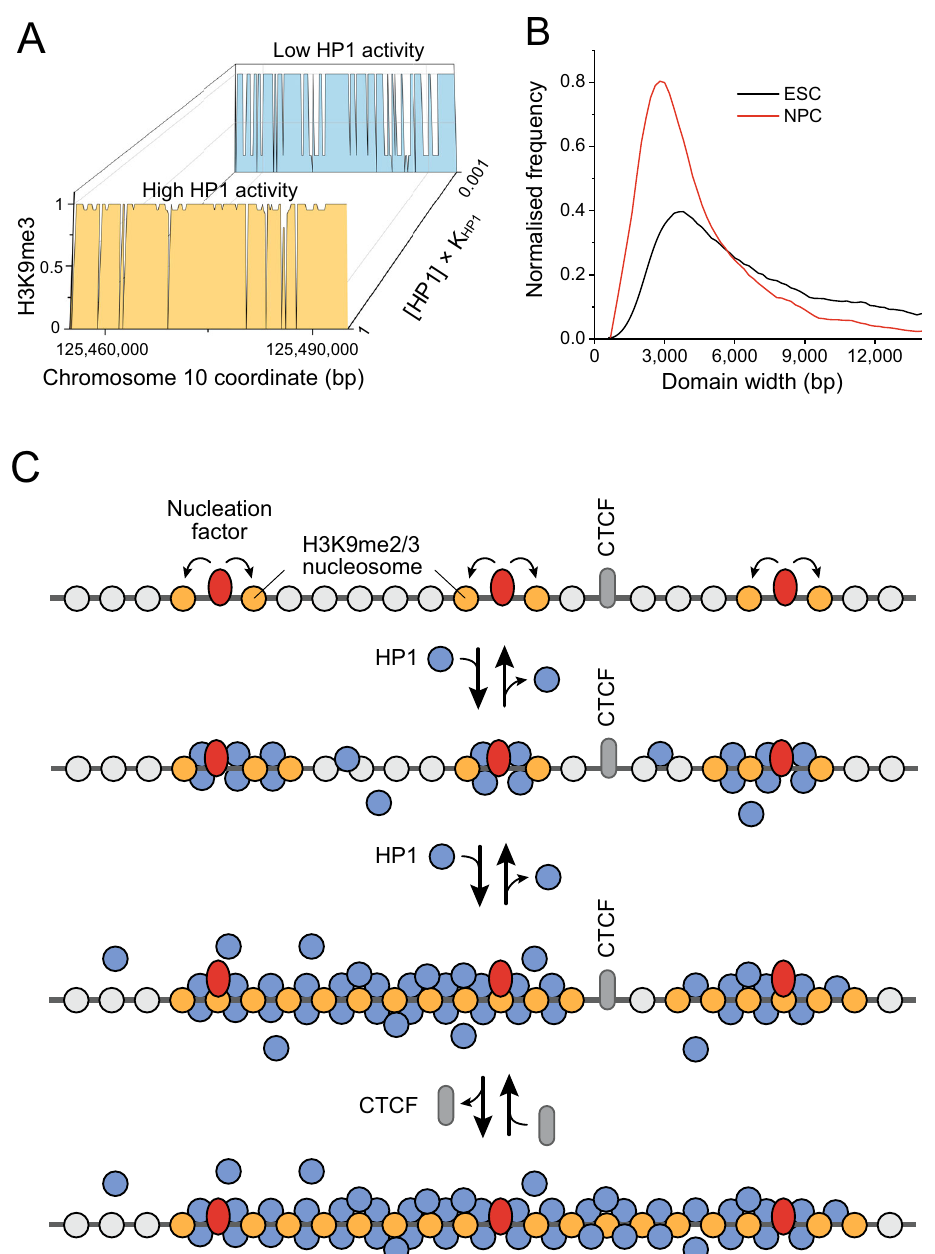
Fig. 6 Dynamics of heterochromatin nanodomains during cell transitions. A Model-predicted heterochromatin state probability for the region centred on chr10:125454974-125464974, for large ([HP1] × K (HP1) = 1) and low concentration of free HP1 molecules ([HP1] × K (HP1) = 0.001). The model predicts that increasing concentration of free HP1 molecules leads to formation of larger heterochromatin domains. B Experimental distributions of H3K9me3 domains in ESCs (black) and NPCs differentiated from them (red). C Schematic model of factors that govern HND features. Heterochromatin nucleation sites are determined by the DNA sequence and concentration of molecules binding these sequences such as Pax3/9 and ADNP. Increasing the HP1 activity (the local concentration of free HP1 molecules) may lead to the broadening of heterochromatin domains, as observed during differentiation of ESC into NPCs 58 . In addition, CTCF binding site occupancy can affect heterochromatin domains